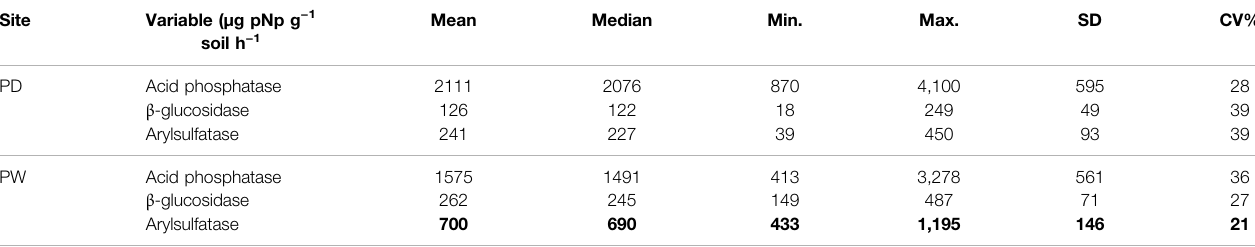
TABLE 4 | Enzyme activities in the surface of the drained and rewetted peatlands.